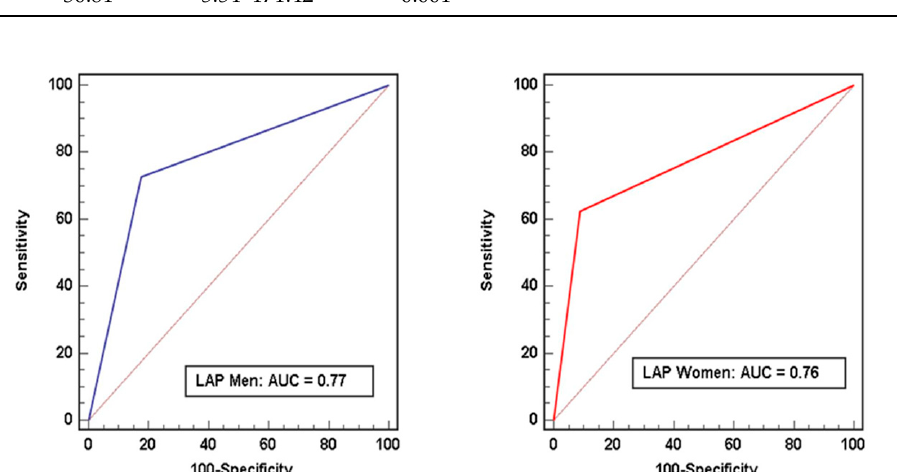
Figure 1. Diagnostic performance of low-attenuation plaque for the prediction of MACE in men and women. Receiver operating characteristics curves with concordant C-indices revealed a C-index of low-attenuation plaque of 0.77 (95%CI 0.72–0.83, p < 0.001) in men and 0.76 (95%CI 0.68–0.84, p = 0.004) in women for outcome prediction. LAP = low-attenuation